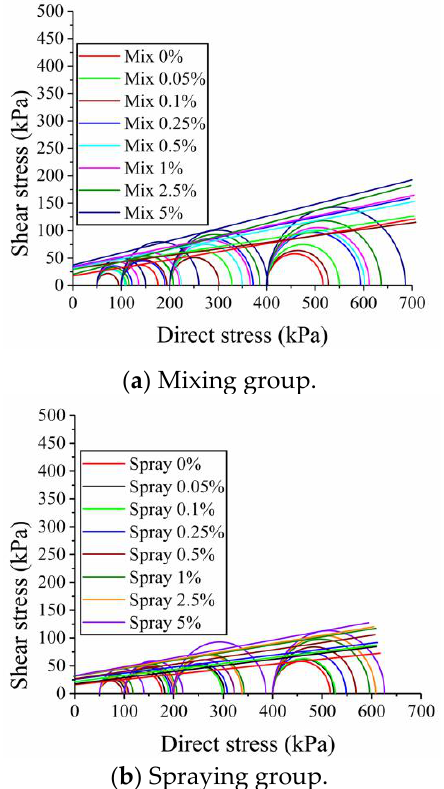
Figure 6. Mohr stress circles.